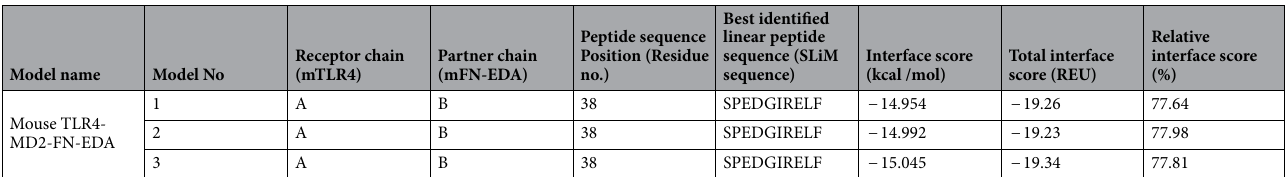
Table 4. SLiM sequences of mFN-EDA identified by Rosetta server (Peptiderive) for filtered TLR4-MD2- FN-EDA docked model complexes. Interface score, binding energy between the determined SLiM